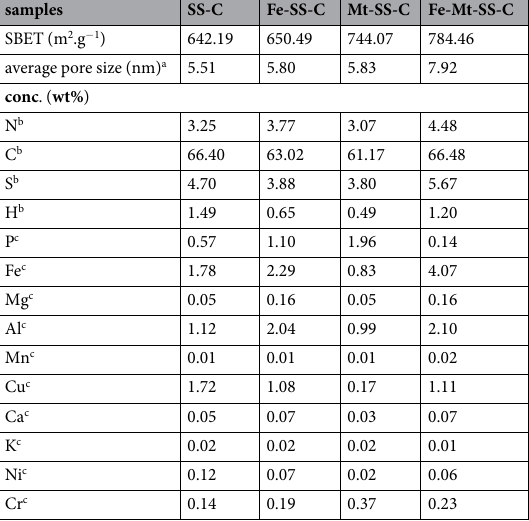
Table 1. Properties of the as-prepared materials. a Calculated from the Barrett-Joyner-Halenda equation using the desorption isotherm. b The contents of C, N, and S were obtained by Elemental Analyze. c The contents of metals were obtained by